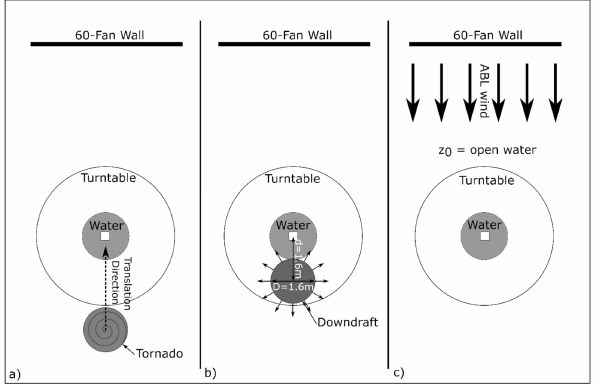
Figure 2. Experimental set up for ( a ) TLVs ( b ) DB outflows ( c ) ABL